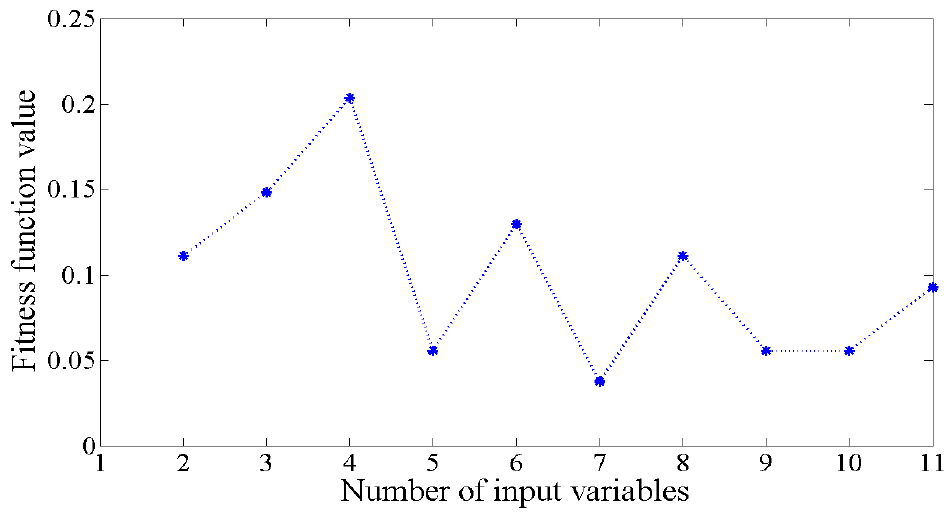
Figure 9. Test data set error values for various input numbers.